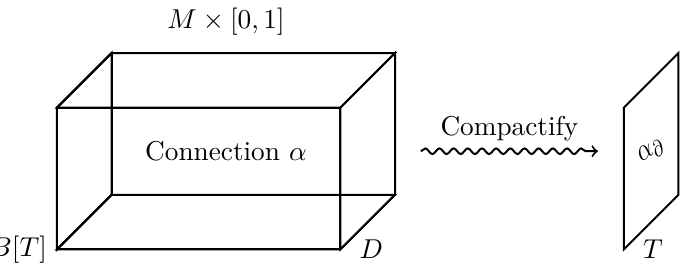
Figure 2 . If we take the boundary condition B [ T ] for the 3d theory we may produce T by compactifying B [ T ] with Dirichlet boundary conditions on M × [0 , 1] . See also appendix